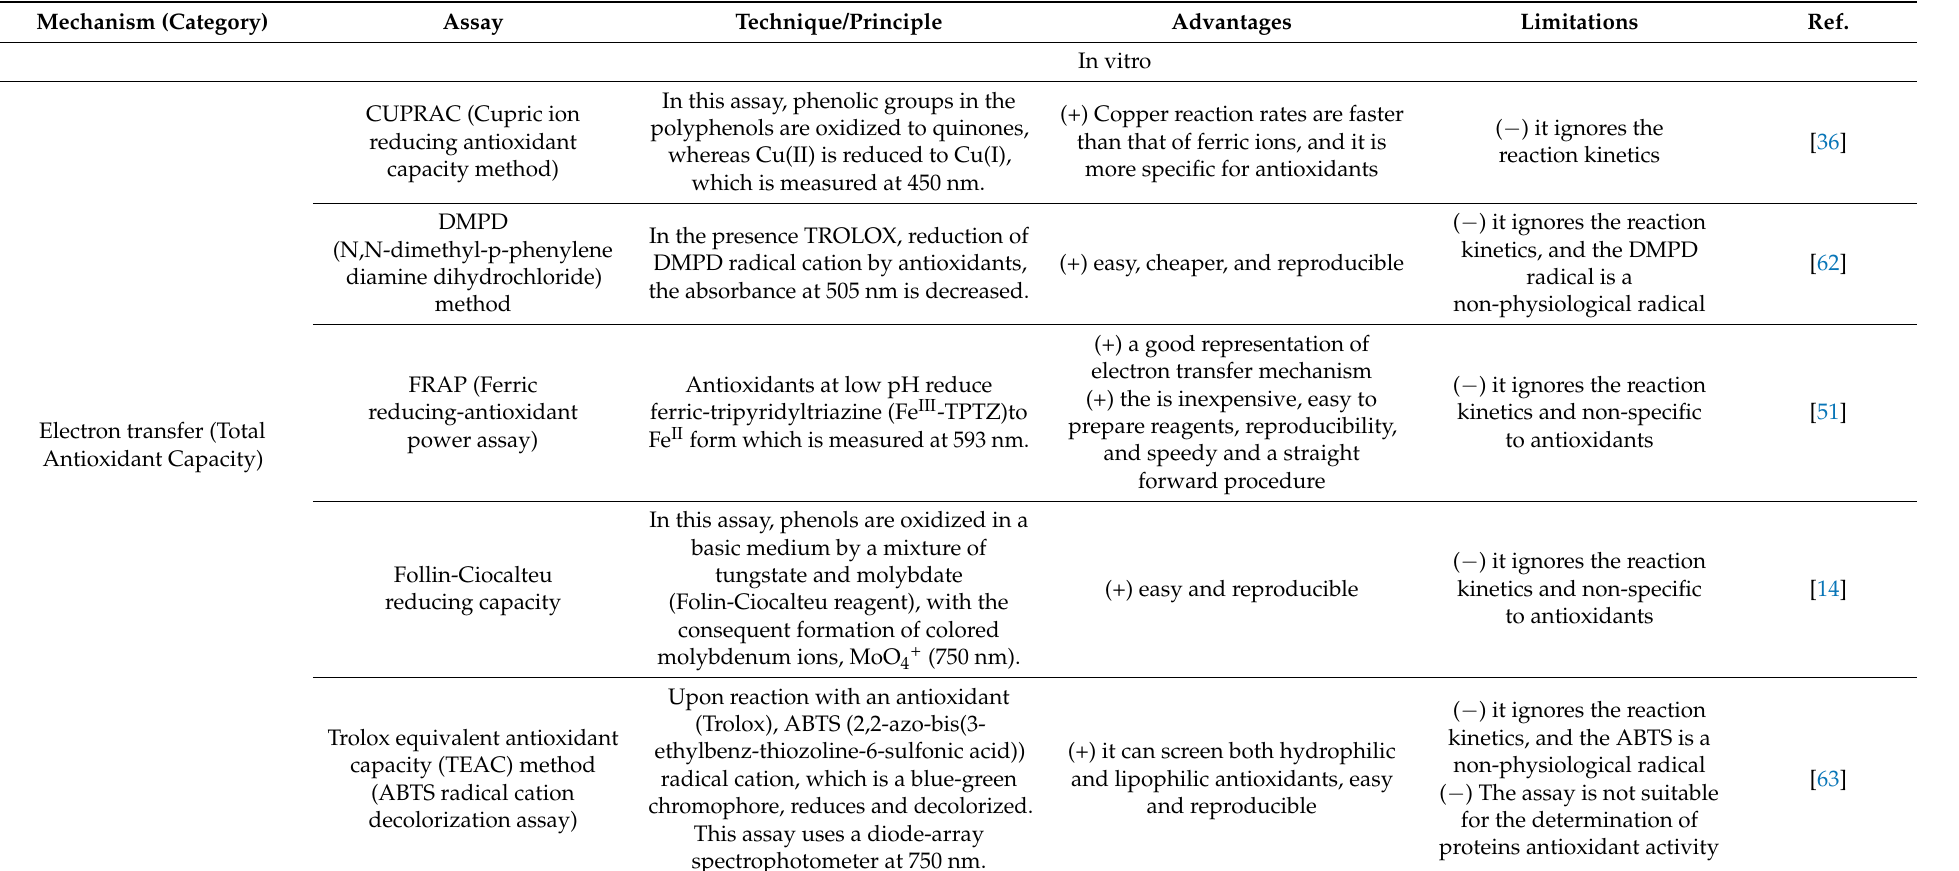
Table 1. Various in vitro and in vivo antioxidant assays, their principles, advantages, and